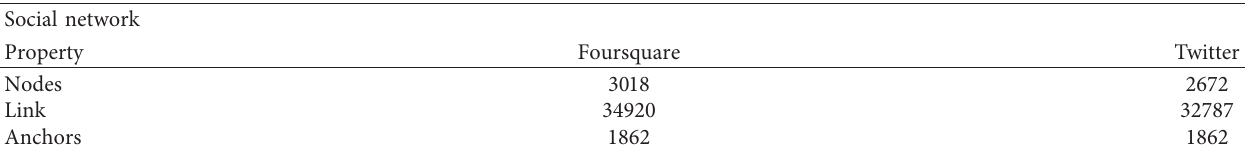
Table 1: Dataset